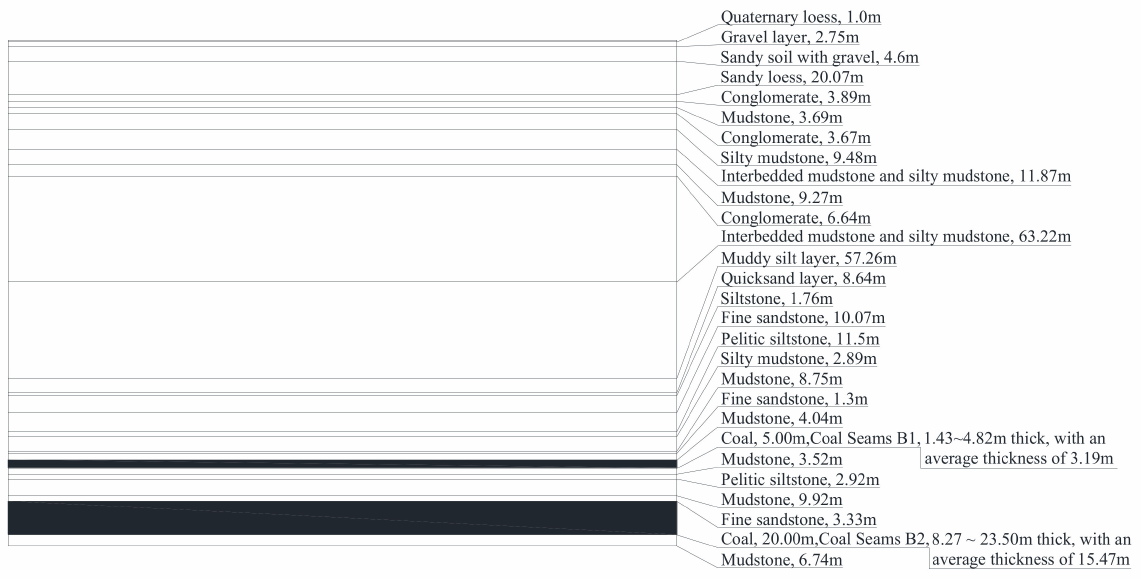
Figure 3. Physical analog model of the 1101 working face in the Baituyao Coal Mine.